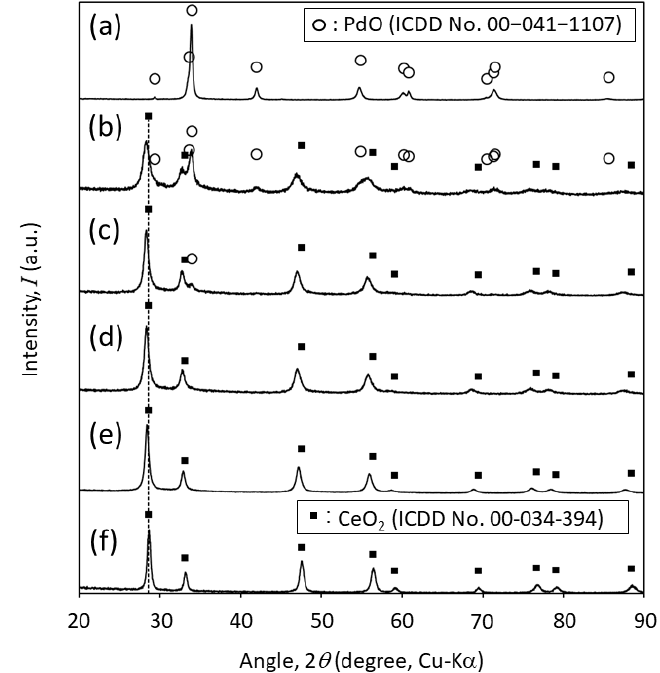
Figure 1. X-ray diffraction (XRD) patterns of prepared powders: ( a ) PdO, ( b ) PdCe1, ( c ) PdCe2, ( d ) PdCe3, ( e ) PdCe4, and ( f ) CeO 2 .